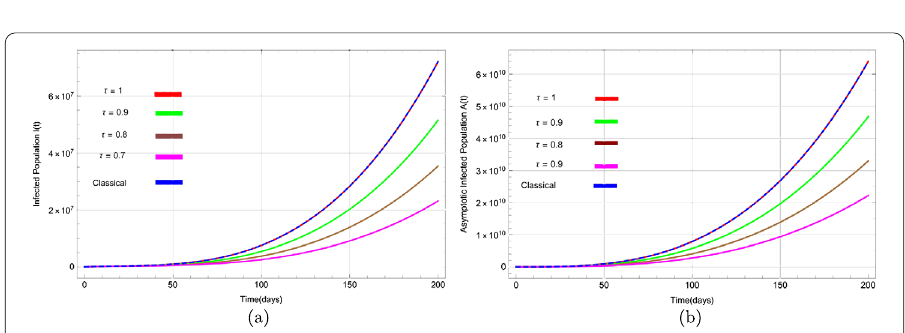
Figure 4 Dynamical behavior of ( a ) infected (symptomatic) population I ( t ) and ( b ) asymptotic population A ( t ) for various values of τ with respect to time